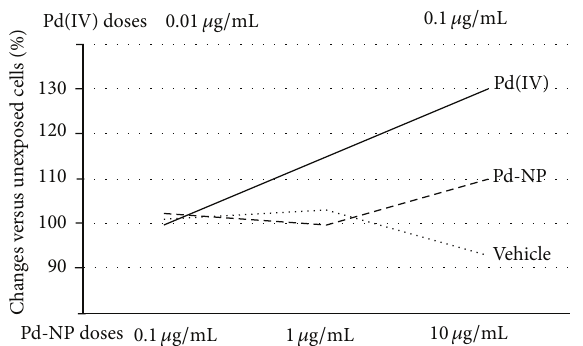
Figure 2: ROS production. Production of ROS by cells exposed to vehicle was similar to that of unexposed cells. Nontoxic concen- tration of Pd-NP induced a moderate, but not significant, change in ROS production in respect to unexposed and vehicle exposed cells, whereas cells stimulated by Pd(IV) ions showed a significant increase in ROS production (by 30% in respect to unexposed cells. 𝑃 < 0.05